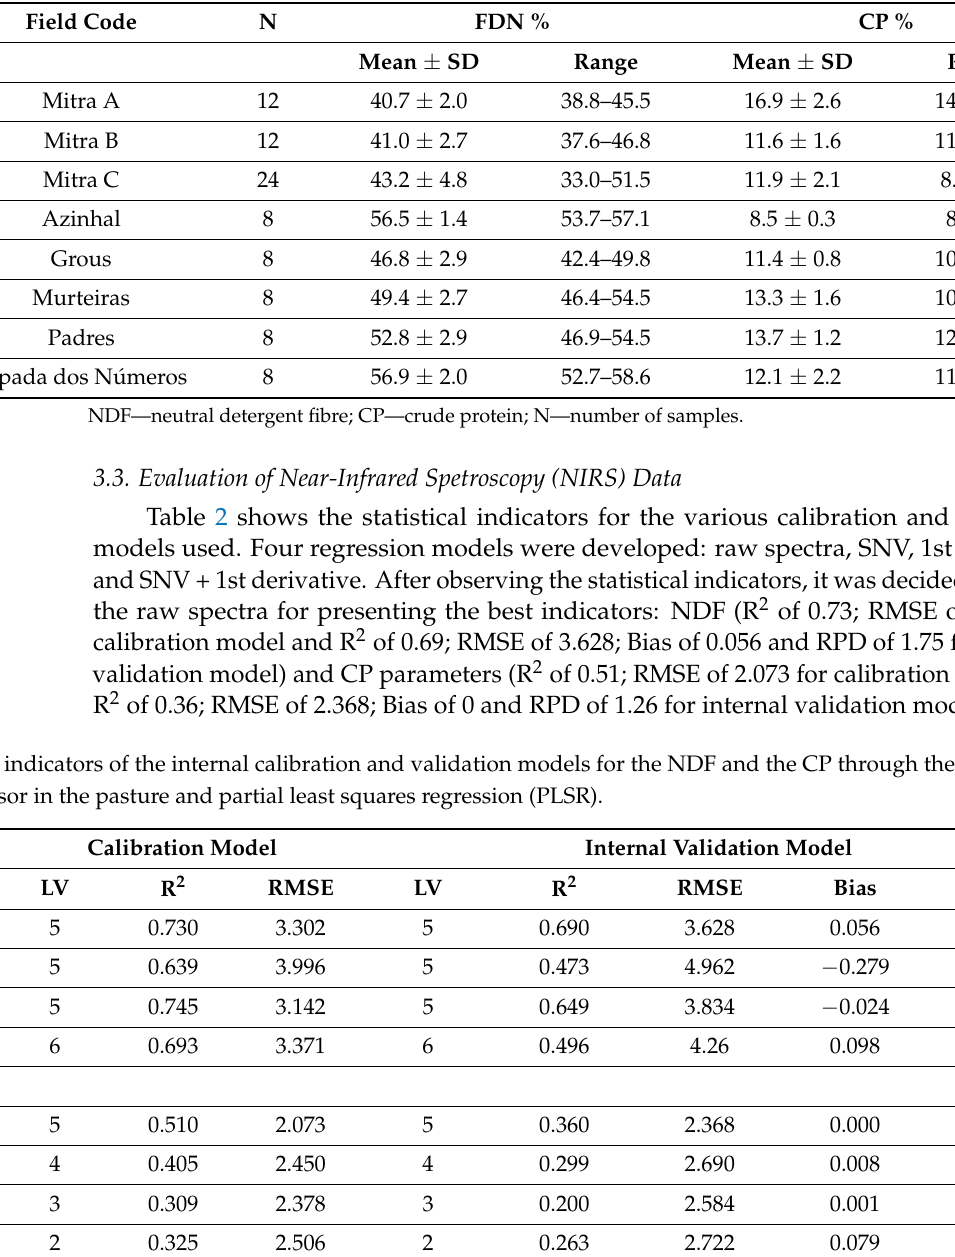
Table 1. Date collection, field code, mean, standard deviation (SD) and range of the pasture NDF and CP reference values.